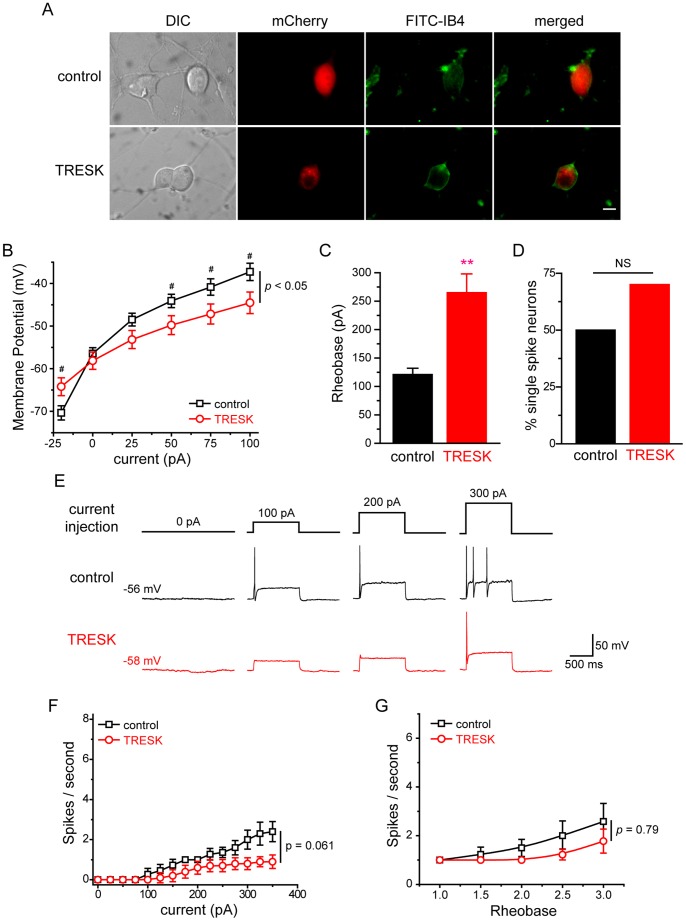
Decrease of excitability in small IB4-positive TG neurons over-expressing TRESK channels.
A, Representative images of the transfected TG neurons stained with FITC-IB4. TG neurons in the control and TRESK groups were transfected with plasmids encoding mCherry protein and mCherry-TRESK subunit, respectively. Scale bar = 10 µm. B, The plot of steady-state membrane potential versus injected current in the control IB4-positive TG neurons is significantly different from that in the TRESK group (p<0.05, two-way RM ANOVA; n = 14 and 10 neurons in the control and TREK groups, respectively). Specifically, the membrane potentials are significantly different between the two groups in response to 20 pA hyperpolarizing current injection as well as to 50∼100 pA depolarizing current injections from the Vrest (#
p<0.05, two-tailed t-test between the corresponding control and TRESK groups). C, Mean rheobase of the small IB4-positive TG neurons expressing mCherry proteins and mCherry-TRESK subunits (*** p<0.001, two-tailed t-test, same neurons as in B). D, The percentage of single-spike neurons in the control and TRESK groups (p = 0.42, Fisher’s exact test, same neurons as in B). E, Representative traces of APs generated by incremental depolarizing current injections in transfected, small IB4-positive TG neurons. The values of Vrest and injected current are indicated. F, The input-output plots of the spike frequency in response to 1 sec depolarizing current injections in 25 pA incremental steps in transfected, small IB4-positive TG neurons (p = 0.061 between the control and TRESK groups, two-way RM ANOVA; same neurons as in B). G, The input-output plots of the spike frequency in response to 1 sec depolarizing current injection from 1- to 3-fold rheobase in transfected, small IB4-positive TG neurons (p = 0.79 between control and TRESK groups, two-way RM ANOVA; same neurons as in B).